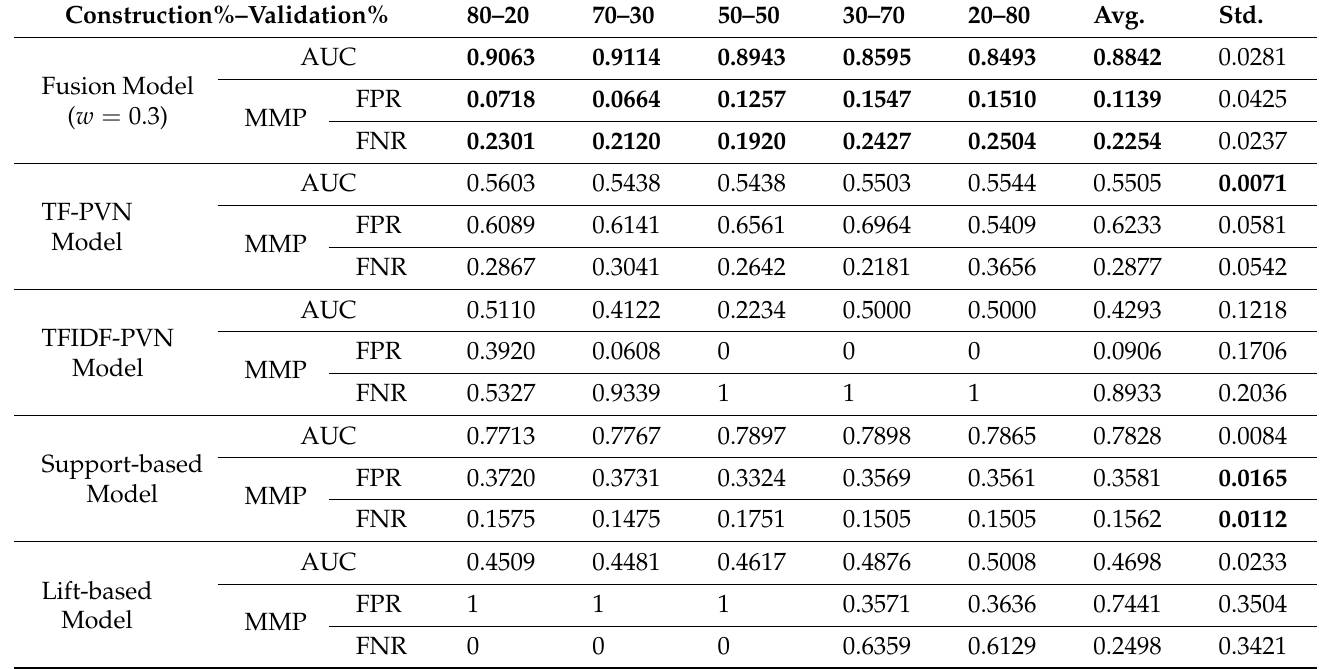
Table 3. Comparison study in terms of AUC and MMP. A number in bold means the corresponding method performs